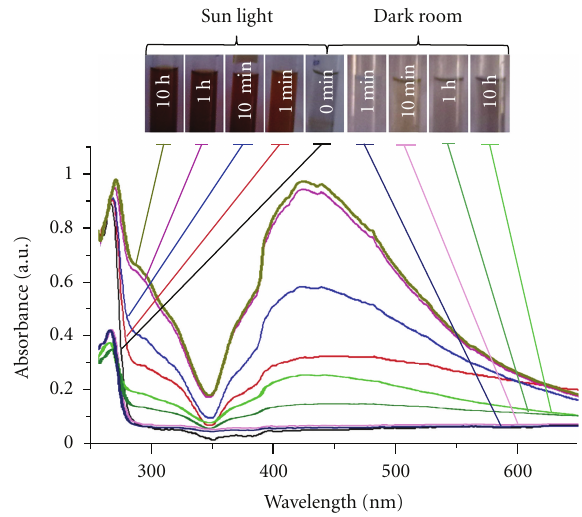
Figure 2: UV-vis spectra indicating the photo-irradiated AgNP synthesis recorded as a function of time. The change in color of the reaction mixture and its respective surface plasmon resonance is shown with the lines.